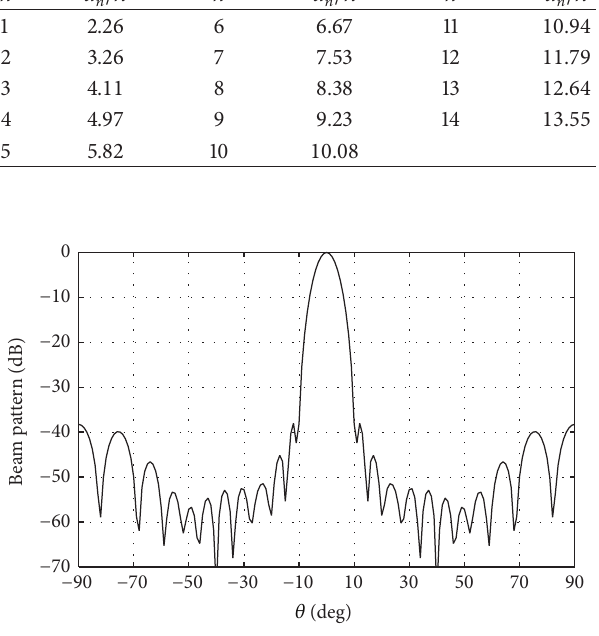
Figure 6: Beam response for the reweighted design